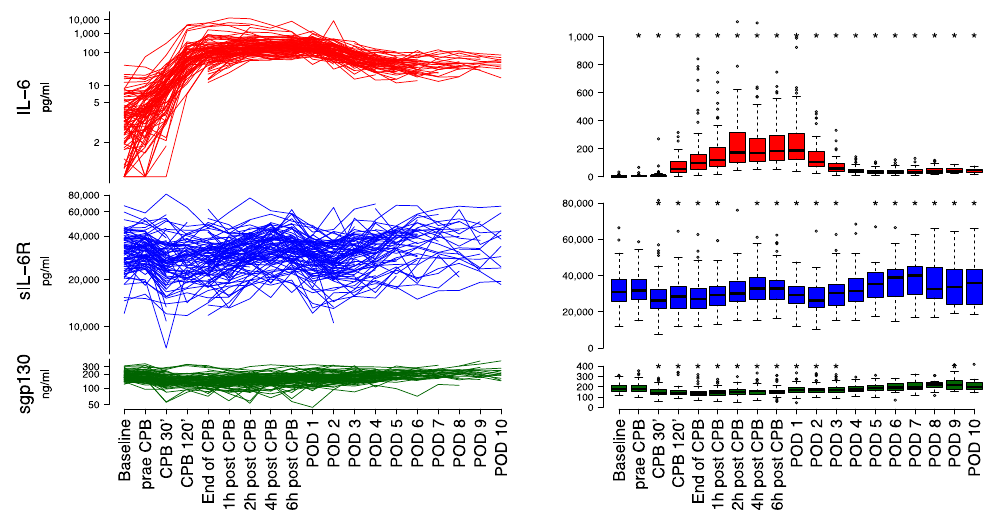
Figure 2. Exaggeration of IL-6, sIL-6R and sgp130. The figure displays individual time course ( left ) and corresponding boxplots ( right ) of perioperative levels of IL-6, sIL-6R and sgp130 levels. The lines on the left are displayed on a a logarithmic scale. Asterisks (*) mark significant differences compared to baseline at p less than 0.05. In the boxplots, the lower boundary of the box indicates the 25th percentile, a black line within the box marks the median, and the upper boundary of the box indicates the 75th percentile. Whiskers above and below the box indicate the 10th and 90th percentiles. Points (°) above and below the whiskers indicate outliers outside the 10th and 90th percentiles (IL-6 outliers above 1200 pg/mL are not shown). Red, blue and green lines indicate IL-6, sIL-6R and sgp130 levels, respectively. Abbreviations: CPB, cardiopulmonary bypass; POD, postoperative day; sgp130, soluble glycoprotein 130; sIL-6R, soluble interleukin-6 receptor.